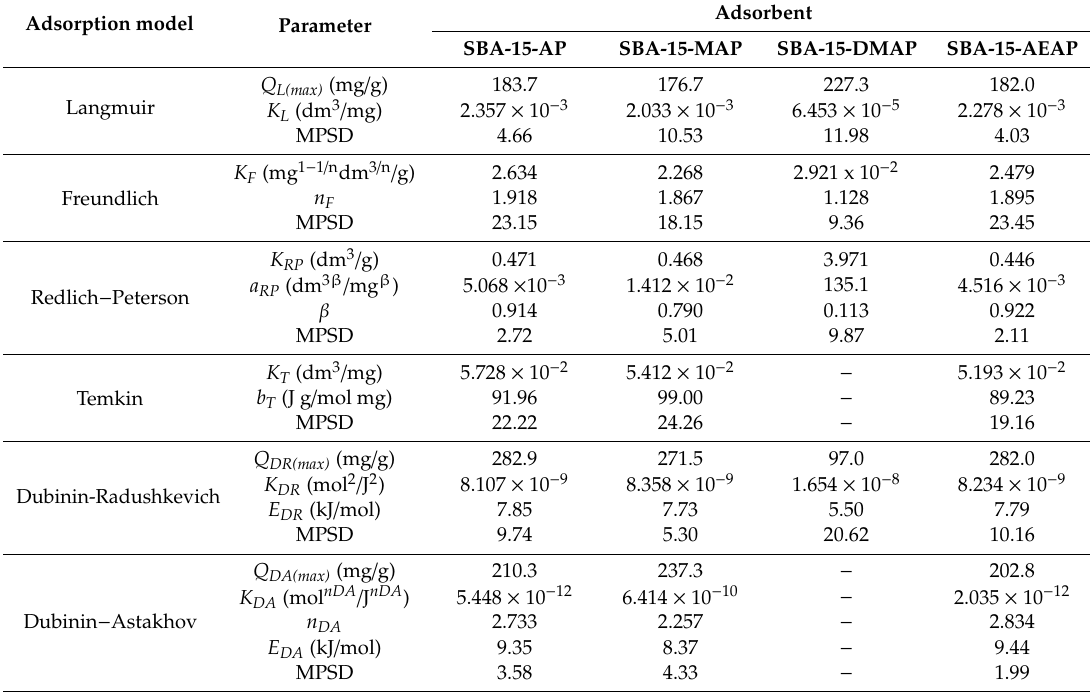
Table 5. Isotherm parameters calculated from nonlinear fitting analysis for 18 β -glycyrrhetinic acid adsorption onto mesoporous silica functionalized with various amine